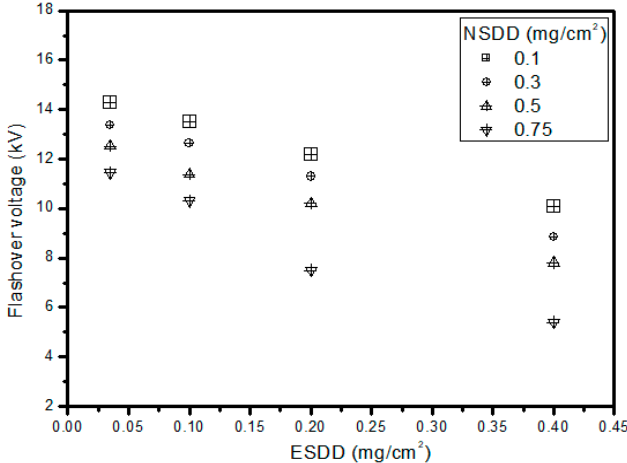
Figure 3. The relationship between NSDD and critical flashover voltage at moderate humidity and 10 °C temperature.